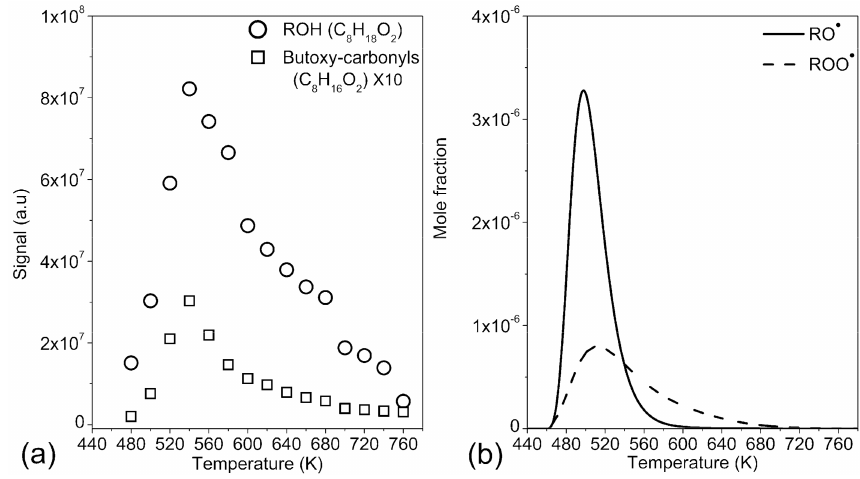
Figure 8. ( a ) Experimental profile of ROH (C 8 H 18 O 2 ) and the sum of R’ (-H) =O (butoxy-ethers) formed during the low-temperature oxidation of di-n-butyl ether. The analyses were performed using UHPLC HRMS and positive APCI. ( b ) Simulated RO • and ROO • radical mole fractions vs. temperature using the model of Thion et al. [14].